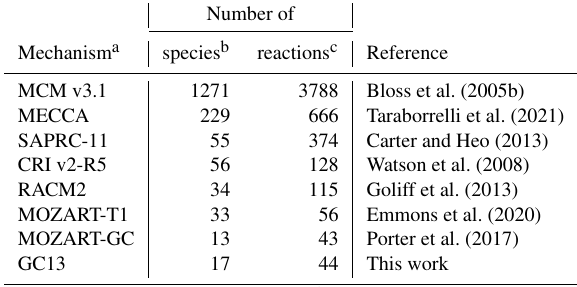
Table 1. Sizes of the aromatic schemes in common